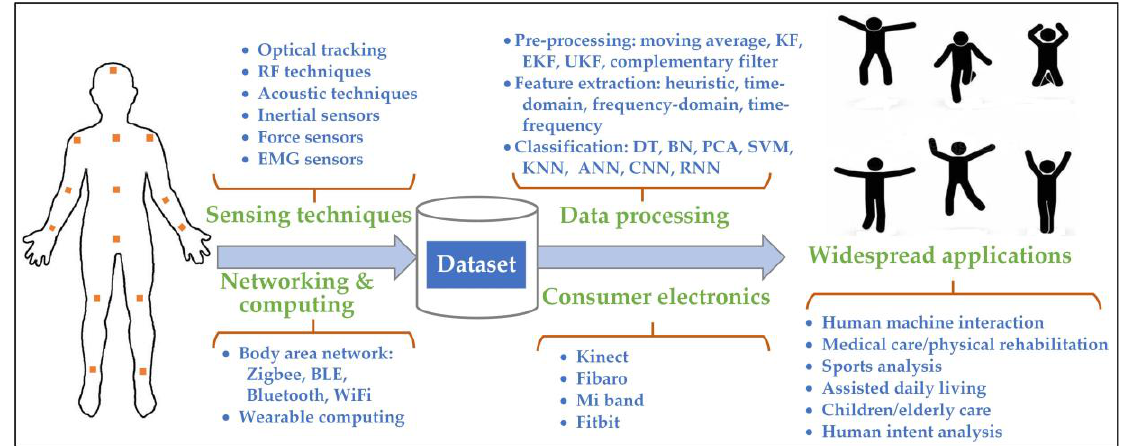
Figure 1. Overview of the latest technical progress of human activity recognition (HAR) investigations.